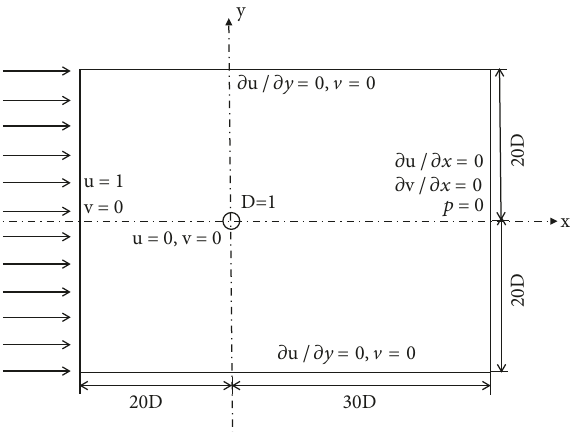
Figure 6: The computation domain and boundary conditions of the flow around a circular cylinder.